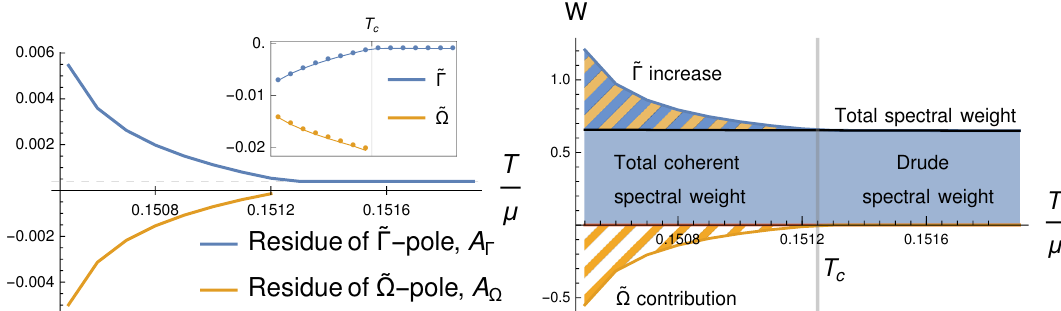
Figure 5. Left panel. The fitting parameters to the AC conductivity at real frequencies (4.1). The positive residue of the ˜Γ -mode, which corresponds to a Drude peak above T gets significantly c enhanced below T , while at the same time the ˜Ω -mode mixes in with negative residue, in agreement c to (4.3). The inset shows the excellent agreement between that the positions of the modes extracted from the fit (lines) and the ones obtained by the imaginary QNM analysis (dots), cf. figure 3. The value of σ is constant in this temperature range ( σ 0 . 35 ) and is not shown. inc inc ≈ Right panel. Redistribution of the spectral weights across the phase transition. Despite the negative contribution of ˜Ω -mode (yellow hatched), it is exactly compensated by the increase of the ˜Γ weight (blue-yellow hatch), therefore the total coherent spectral weight (blue) is constant across T . Note c also that the spectral weight due to incoherent part of conductivity (not shown) is insensitive to the phase